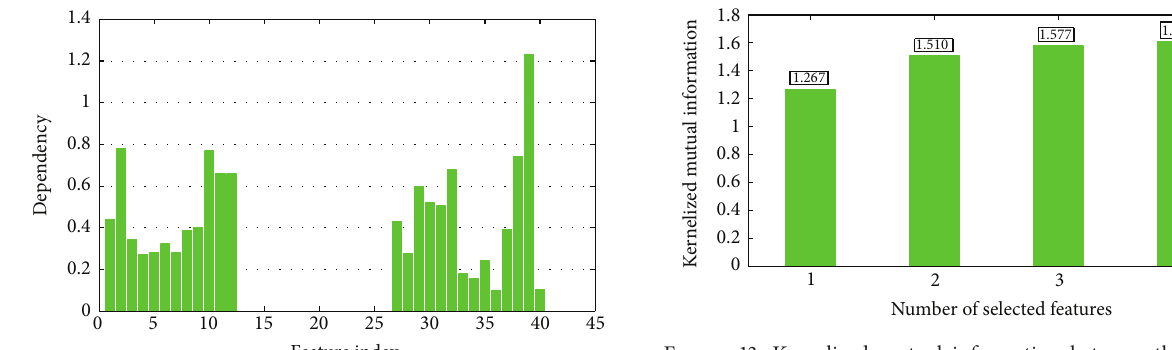
Figure 13: Kernelized mutual information between the selected features and decisions (Features 39, 31, 38, and 40 are selected